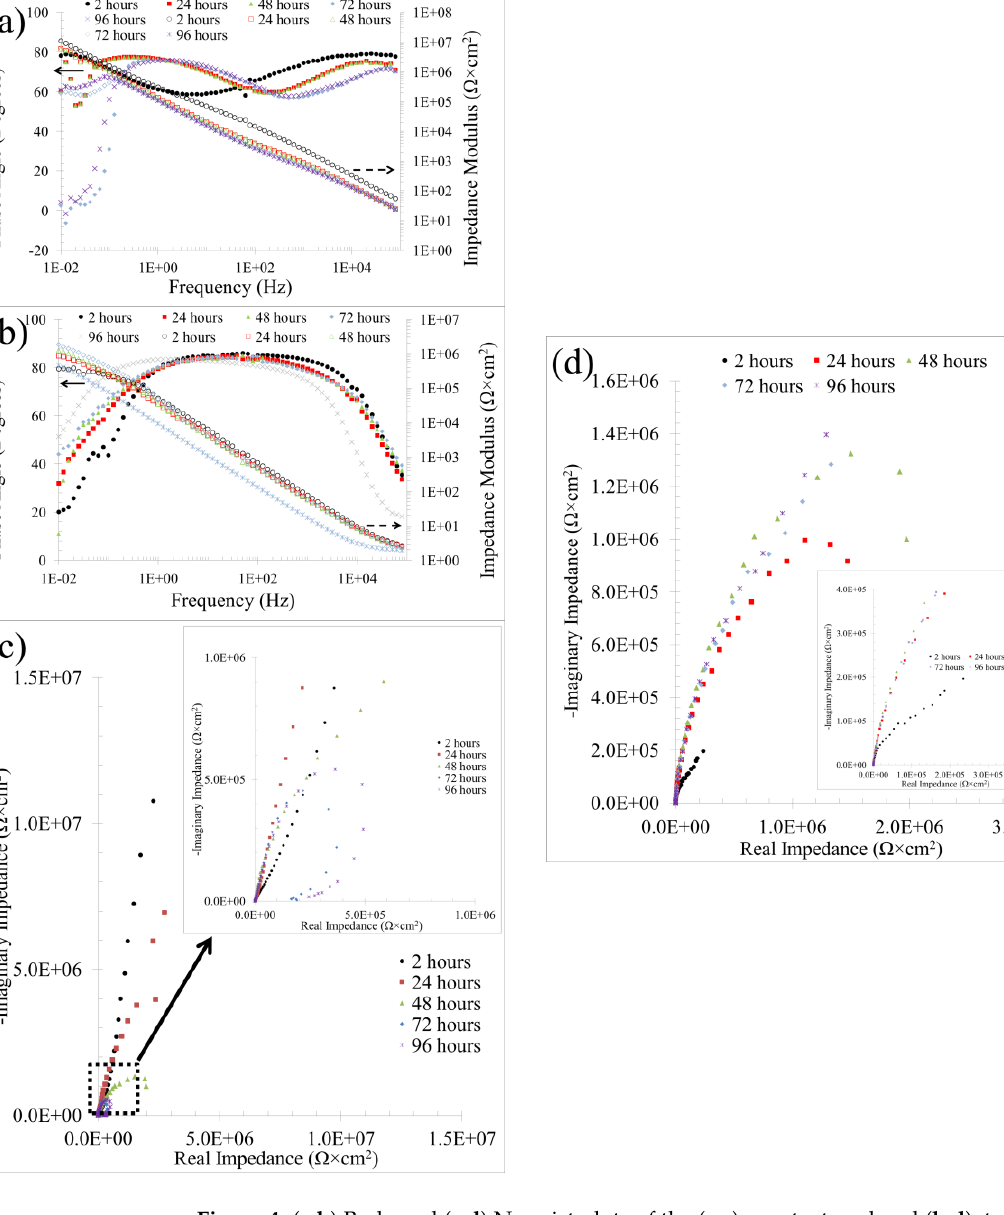
Figure 4. ( a , b ) Bode and ( c , d ) Nyquist plots of the ( a , c ) non-textured and ( b , d ), textured samples at all immersion times in 0.6 M